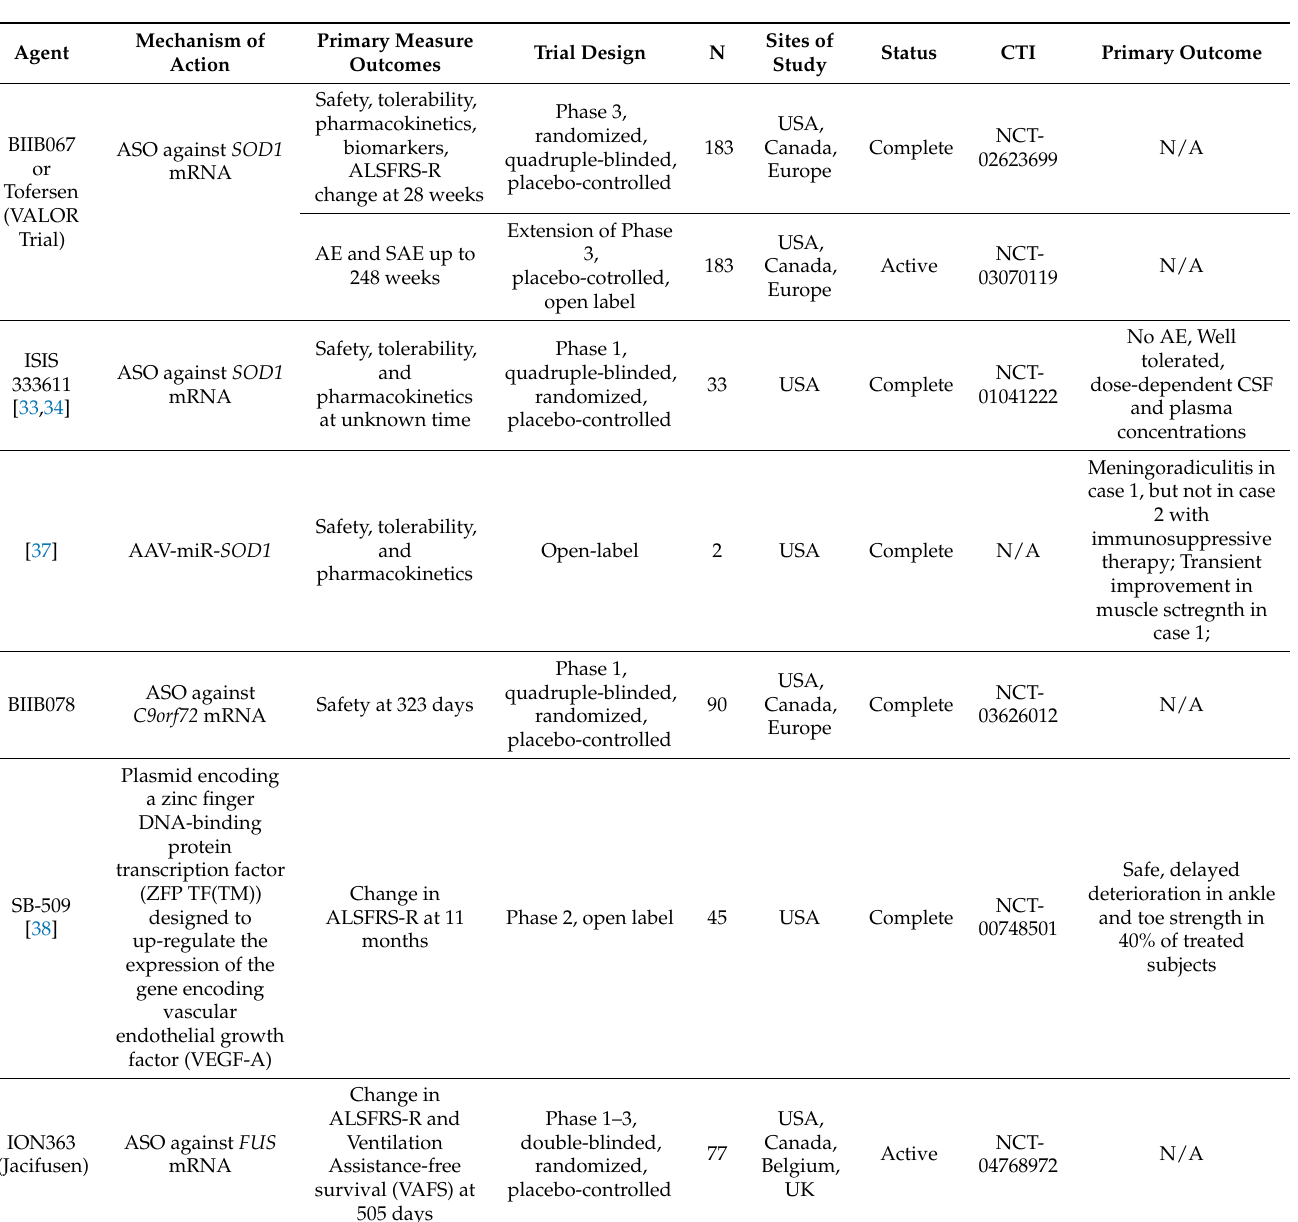
Table 1. Gene Therapy Clinical Trials in Amyotrophic Lateral